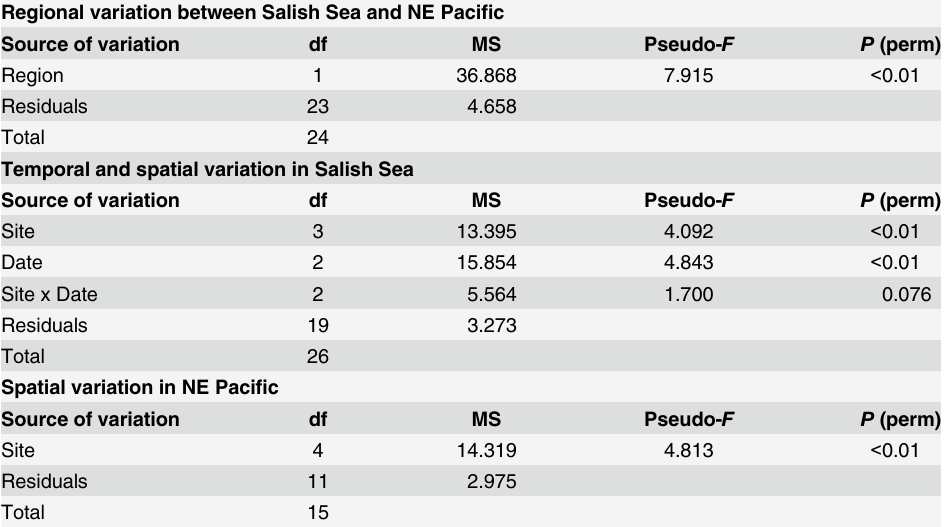
Table 2. Permutational analysis of variance (PERMANOVA) results testing the effect of sampling date and location on benthic fluxes based on Euclidean similarity matrices performed on normalized data.